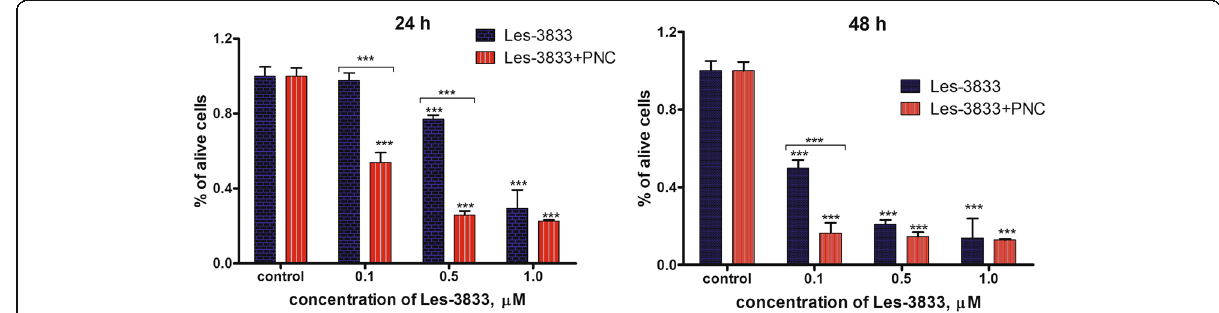
Fig. 6 Number of living rat glioma C6 cells measured by Trypan blue exclusion test after treatment for 24 h and 48 h with different concentrations (0.1, 0.5, and 1.0 μ M) of Les-3833 alone compared with the action of its complex with the polymeric nanocarrier (PNC) *P < 0.05; **P < 0.01; ***P < 0.001 (difference in comparison to the control,